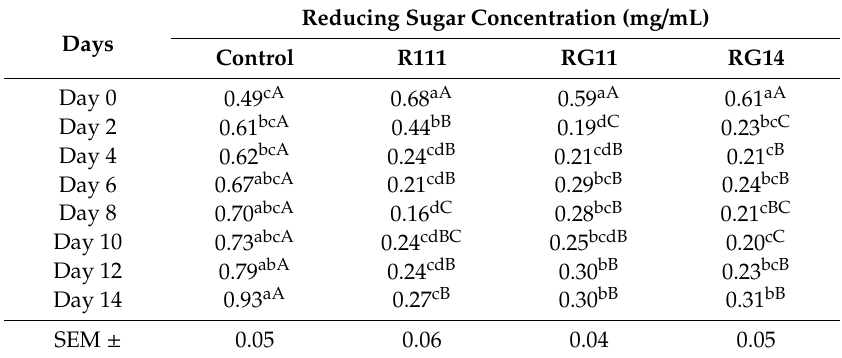
Table 1. Reducing sugar concentration of untreated and treated palm kernel cake